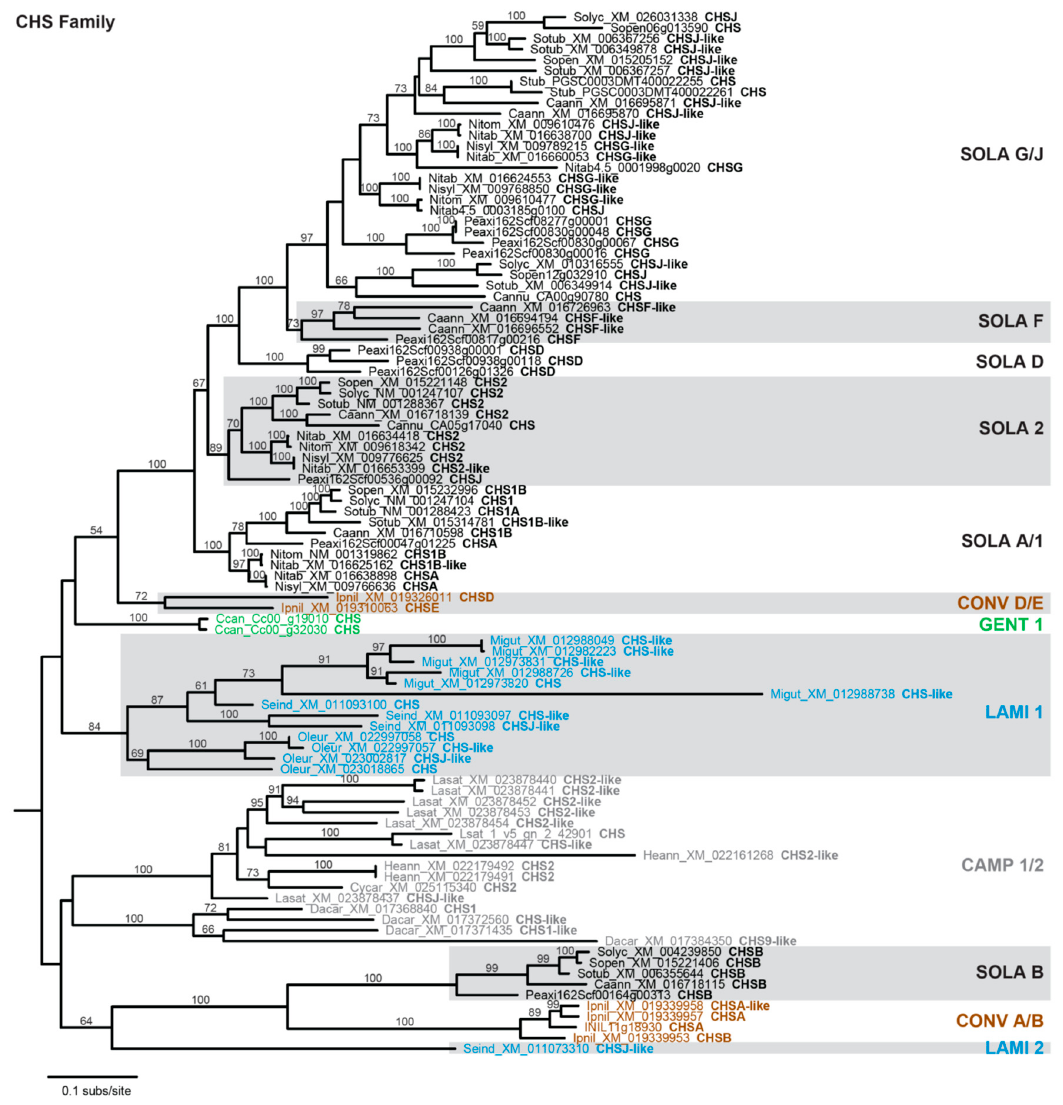
Figure 2. Phylogram depicting phylogenetic relationships among CHS family homologs. Taxon names include a species abbreviation, a GenBank accession number or gene ID, and the Chalcone synthase (CHS) subfamily designation taken from the accession. Bootstrap values > 50% are shown. Monophyletic clades are labeled as described in text and color-coded according to phylogenetic grouping: Campanulids, gray; Convolvulaceae, brown; Gentianales, green; Lamiales, blue; Solanaceae, black. Non-asterid sequences used to root the tree are not